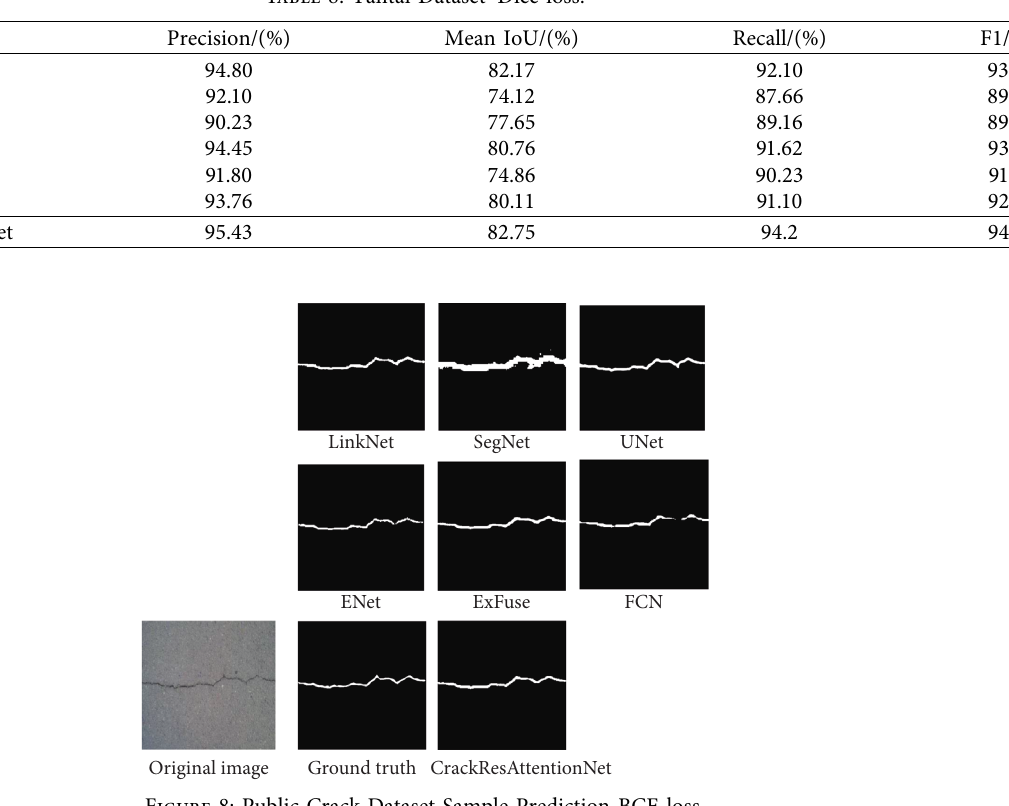
Table 8: Yantai Dataset–Dice loss.